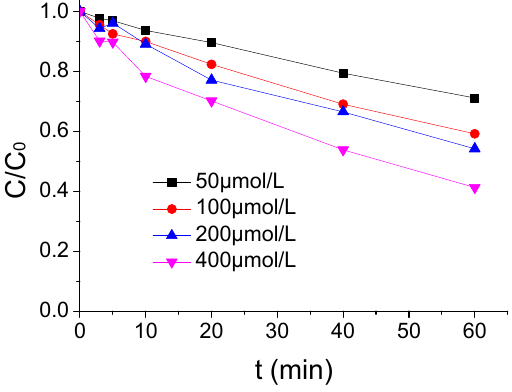
ff erent PMS density ( C = 1.25 µ mol / 0